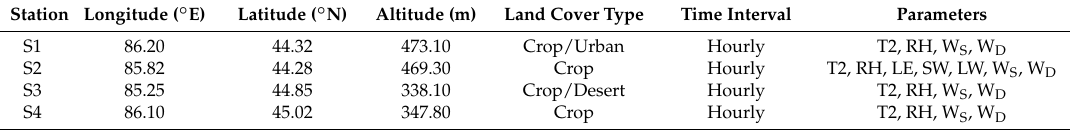
Table 1. Station information and parameters measured at each